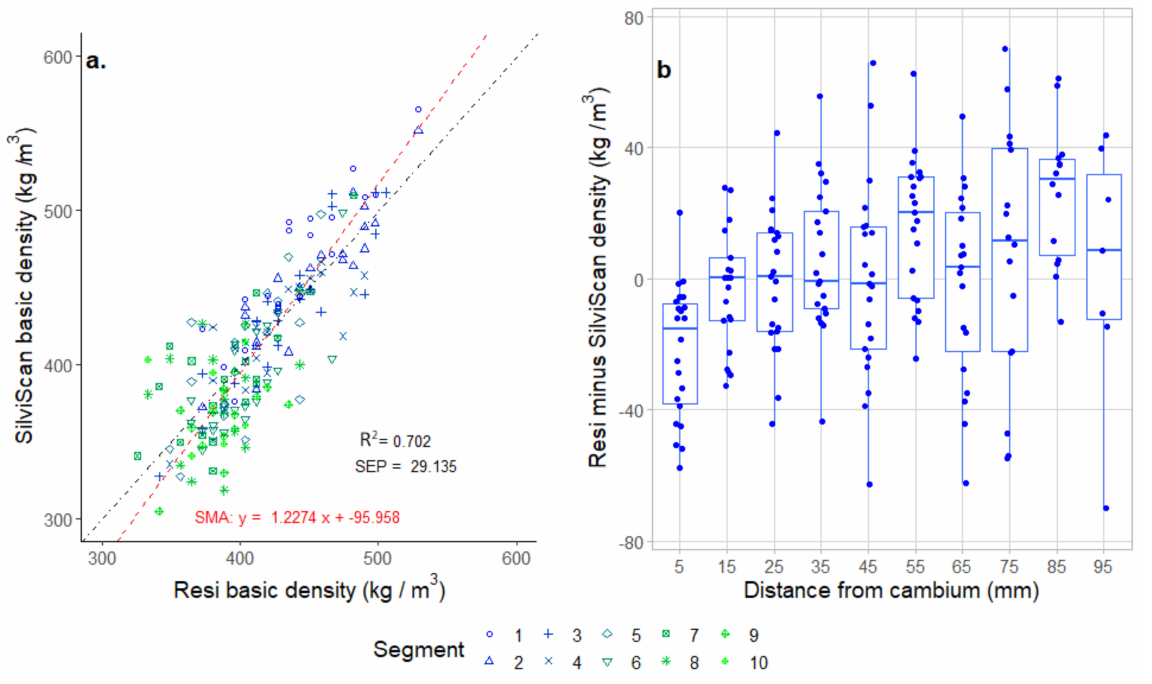
Figure 8. ( a ) The mean Resi-predicted density of 20 mm segments was compared to the SilviScan density values for each Resi instrument. ( b ) The effect of distance from the cambium on the difference between SilviScan and Resi mean basic